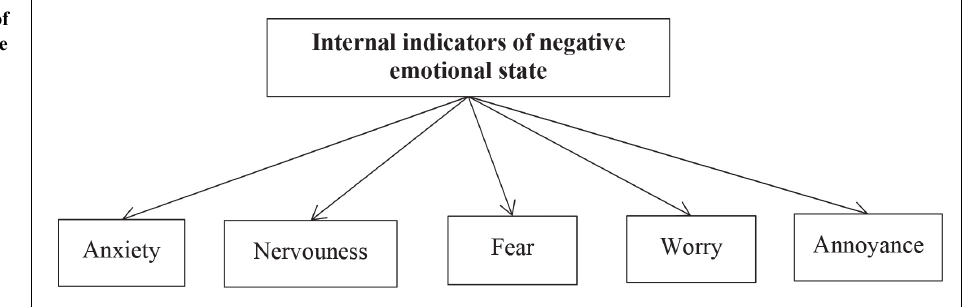
Figure 5. The main in - ternal indicators of negative emotional